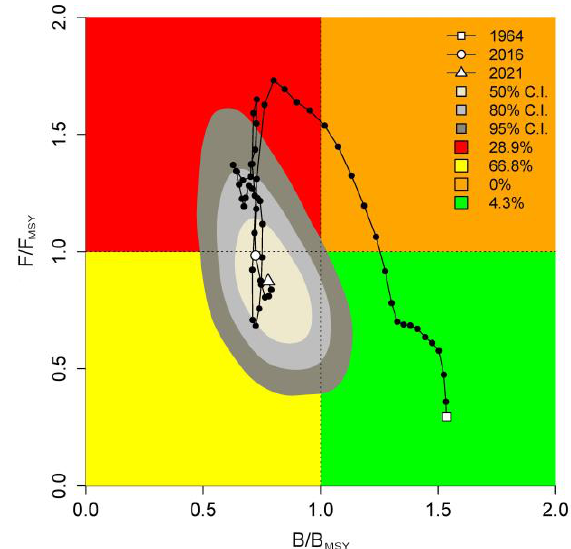
Figure 3. KOBE phase plot obtained with the CMSY++ method, representing the time series of exploitation rate (F/F MSY ) and relative stock size (B/B MSY ) of Raja clavata in the Balearic Islands during the period 1964–2021. Colour code: red (top-left quadrant), F/F MSY > 1 and B/B MSY < 1 (experiencing overfishing and overfished); orange (top-right quadrant), F/F MSY > 1 and B/B MSY > 1 (healthy stock size about to be depleted by overfishing); yellow (bottom-left quadrant), F/F MSY > 1 and B/B MSY < 1 (reduced fishing pressure on stock recovering from low biomass level); green (bottom- right quadrant), F/F MSY > 1 and B/B MSY < 1 (sustainably exploited). CI: confidence